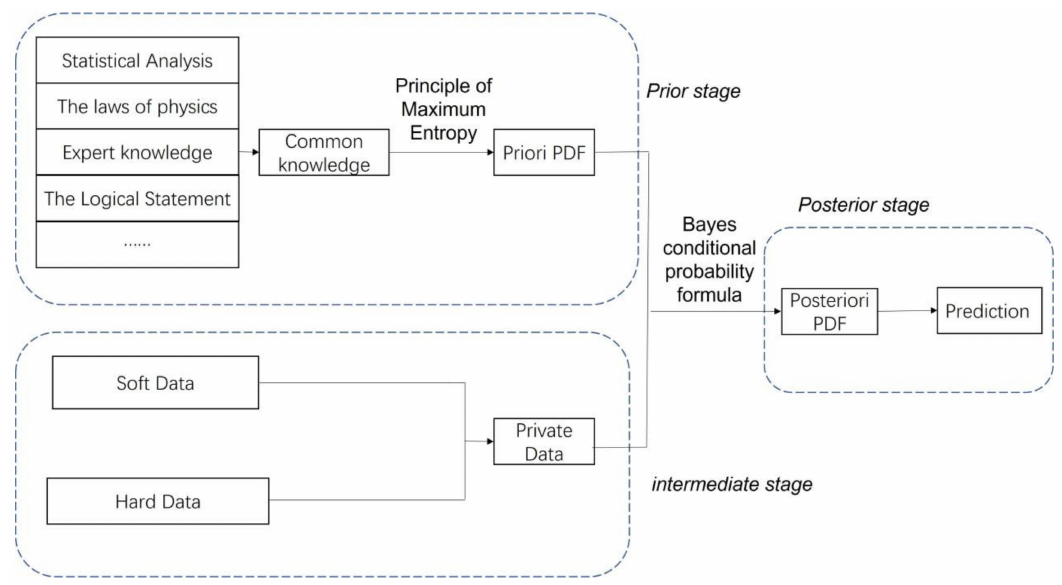
Figure 2. Workflow of the BME